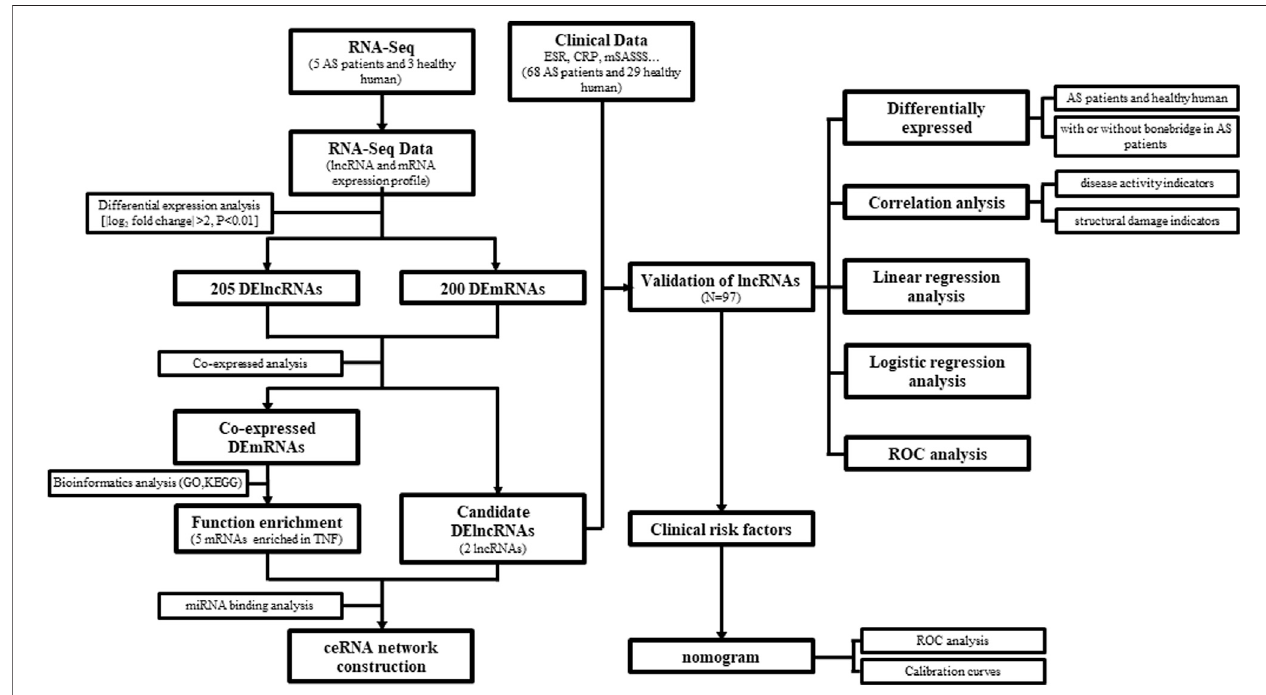
FIGURE 1 | Overall design and fl